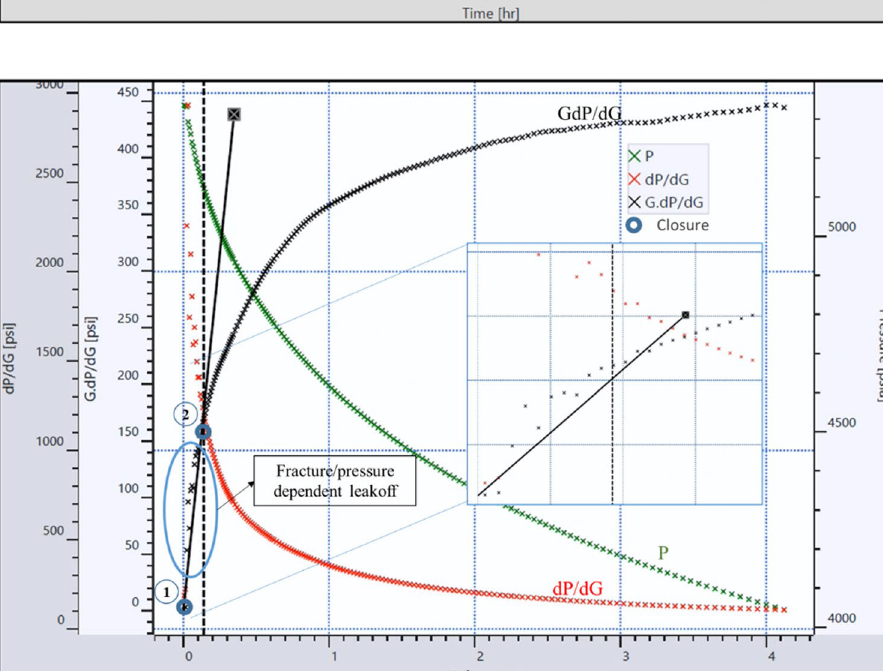
Fig. 7 Log–log diagnostic plot for Cycle #2. The ½ slope in the semilog drawdown derivative curve implies fracture linear flow. The reduction in the semi- log drawdown derivative from a ½ slope is representative of closure. Drawdown derivative is (∆ t d∆ P /d∆ t ), and semilog derivative refers to the Bourdet derivative